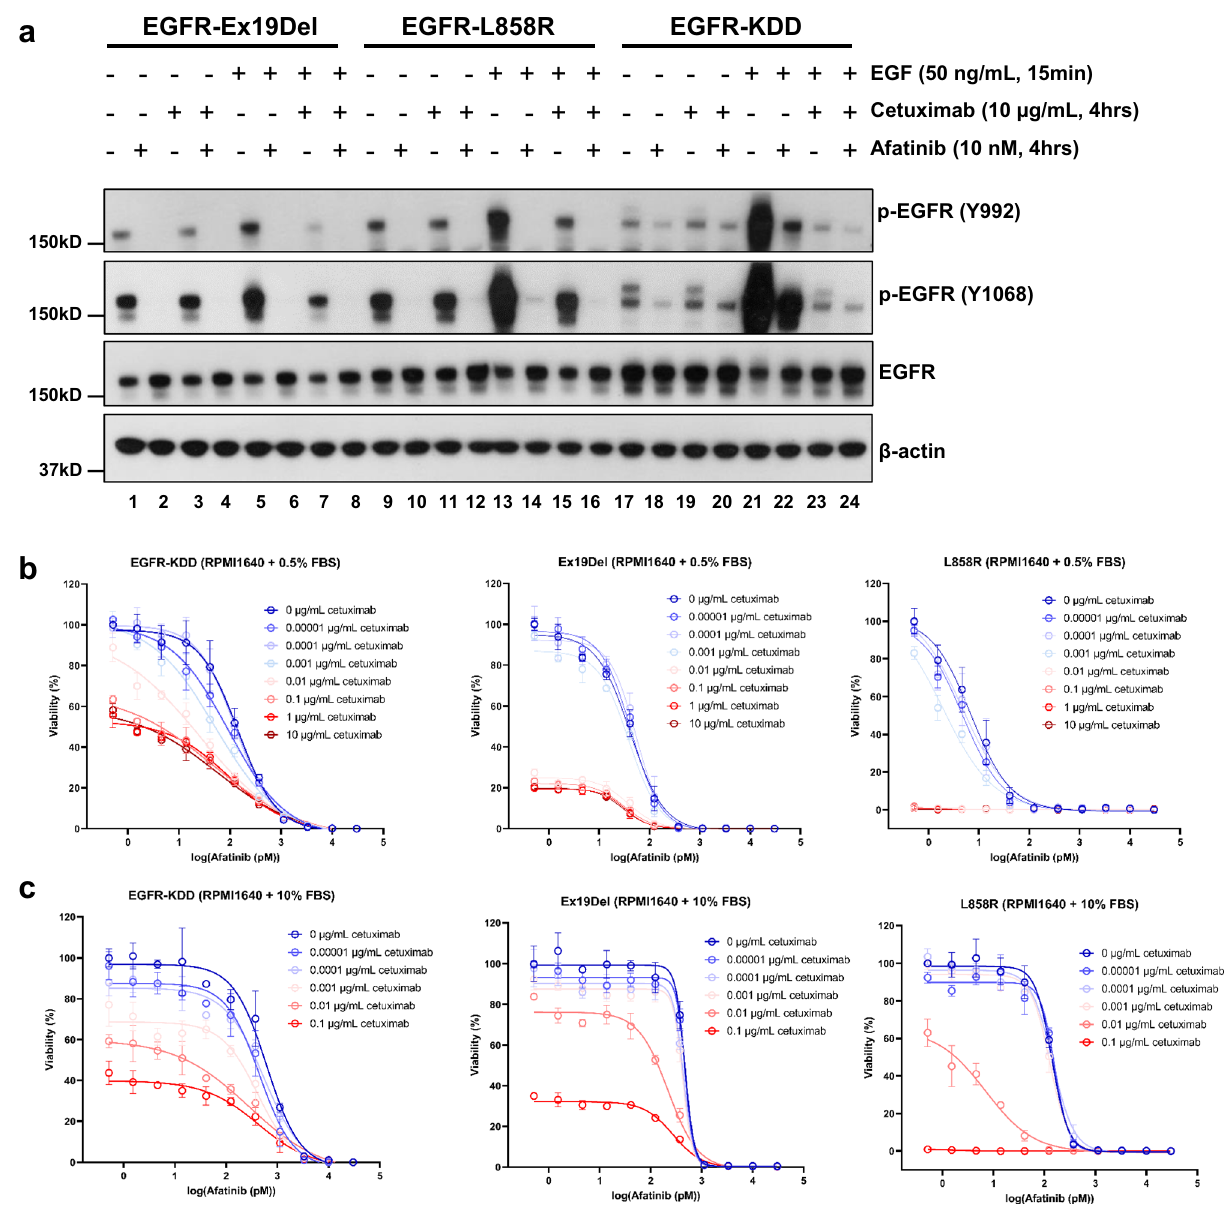
Fig. 5 Inhibition of EGFR-KDD is maximally achieved by blocking both intra- and inter-molecular dimerization. a YAMC cells were starved for 12h and treated with afatinib (10nM in serum-free medium) and cetuximab (10 µ g/ml in serum-free medium) for 3h 45min, and then were treated with EGF (50ng/ mL in serum-free medium) for 15min. The cells were harvested and analyzed by Western blot. b Cell Viability Assay was performed in mIL3-independent Ba/F3 cells stably expressing EGFR-KDD, Ex19Del and L858R supplemented with 0.5% FBS. c Cell Viability Assay was performed in mIL3-independent Ba/F3 cells stably expressing EGFR-KDD, Ex19Del, and L858R supplemented with 10% FBS. For a , n = 3 experiments were repeated independently with similar results. For b and c , n = 3 biologically independent replicates were examined over three independent experiments with similar results. Data are presented as mean values± SD. Results in a, b and c are the representative of three independent experiments. Source data are provided as a Source Data fi (Fig. 5a, lanes 7, 15, 23). Notably, the greatest reduction of We also performed viability assays with BaF3 cells stably phosphorylation for EGFR-KDD occurred with the combination expressing EGFR-KDD, Ex19Del (E746_A750del) or L858R. of cetuximab + afatinib in the presence of EGF (Fig. 5a, lanes 21, First, we evaluated Ba/F3 cell growth in serum starved (0.5% 22, 23, 24). These data suggest that phosphorylation of EGFR fetal bovine serine; FBS) conditions to minimize EGF activation Ex19Del and L858R is abolished by afatinib (TKI) or cetuximab (Supplementary Fig. 7b). At 0.5% FBS, cetuximab maximally alone, and addition of cetuximab to afatinib does not add exhibited ~40% inhibition of EGFR-KDD, ~80% inhibition of substantially more inhibition to the decrease in auto- Ex19Del, and almost 100% inhibition of L858R cell viability phosphorylation. Unlike EGFR Ex19Del and L858R, phosphor- (Fig. 5b and Supplementary Table 3). These data are consistent ylation of EGFR-KDD is inhibited by both afatinib and cetuximab with a model in which EGFR-KDD retains an active intra- as single agent, but the combination treatment yielded more molecular dimer in the absence of EGF stimulation (Fig. 1) and inhibitory effects. previously published models of Ex19Del and L858R in which